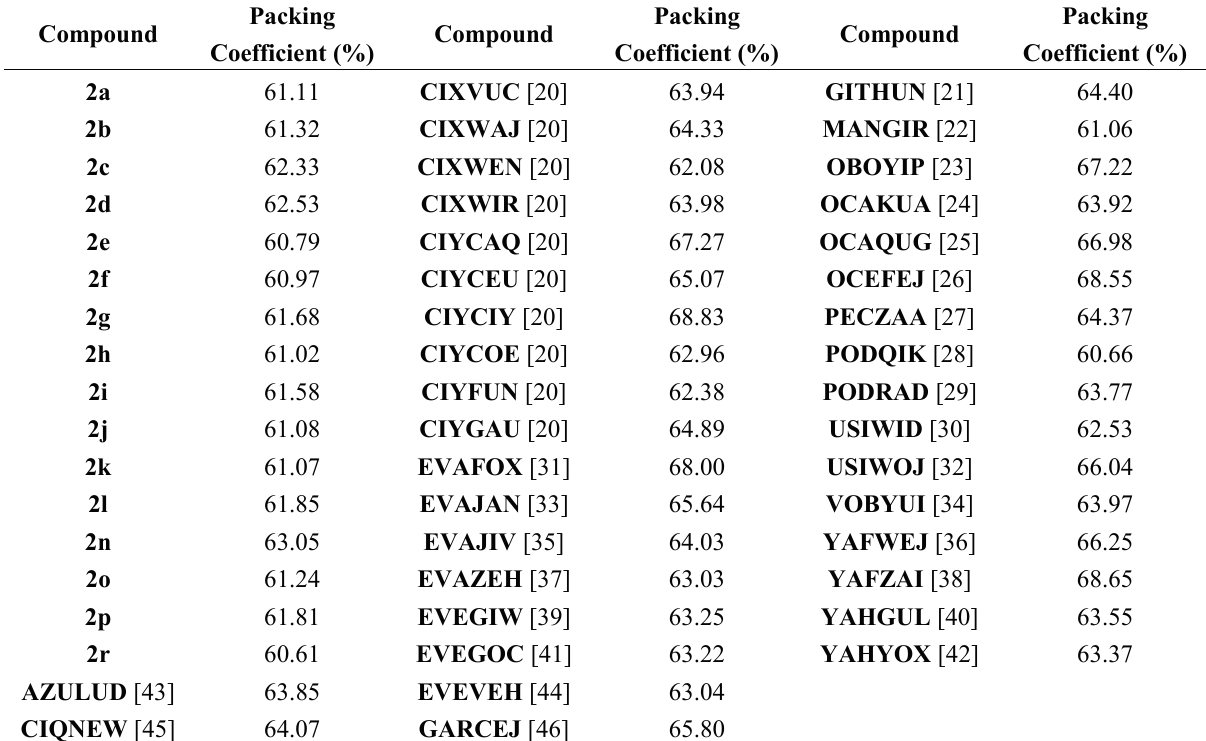
Table 3. List of the structural occupancy of the present and reported compounds i .